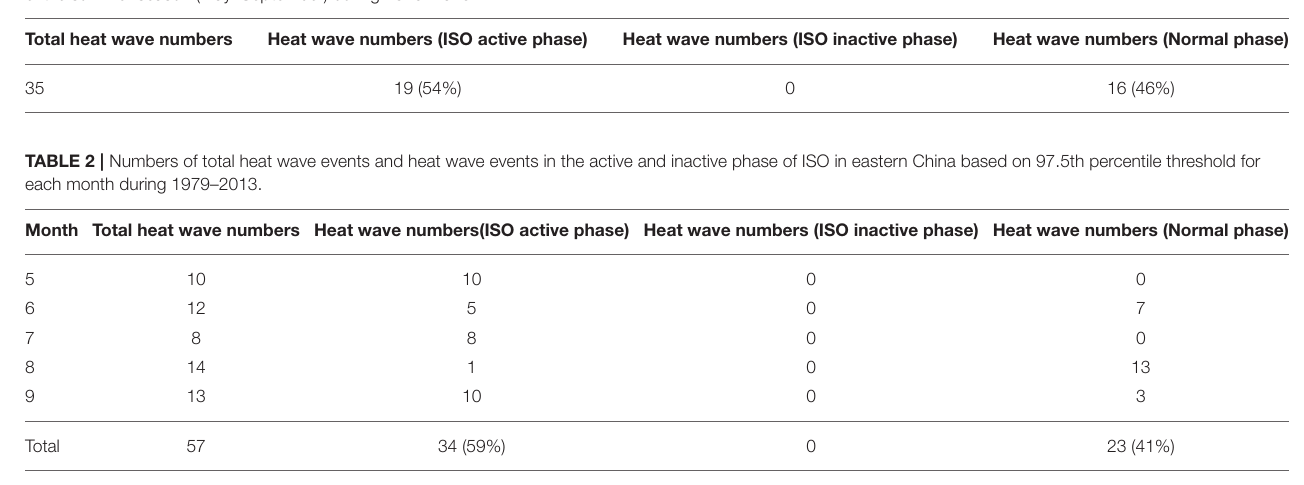
TABLE 1 | Numbers of total heat wave events and heat wave events in the active and inactive phase of ISO in eastern China based on 97.5th percentile threshold for the entire summer season (May–September) during 1979–2013.